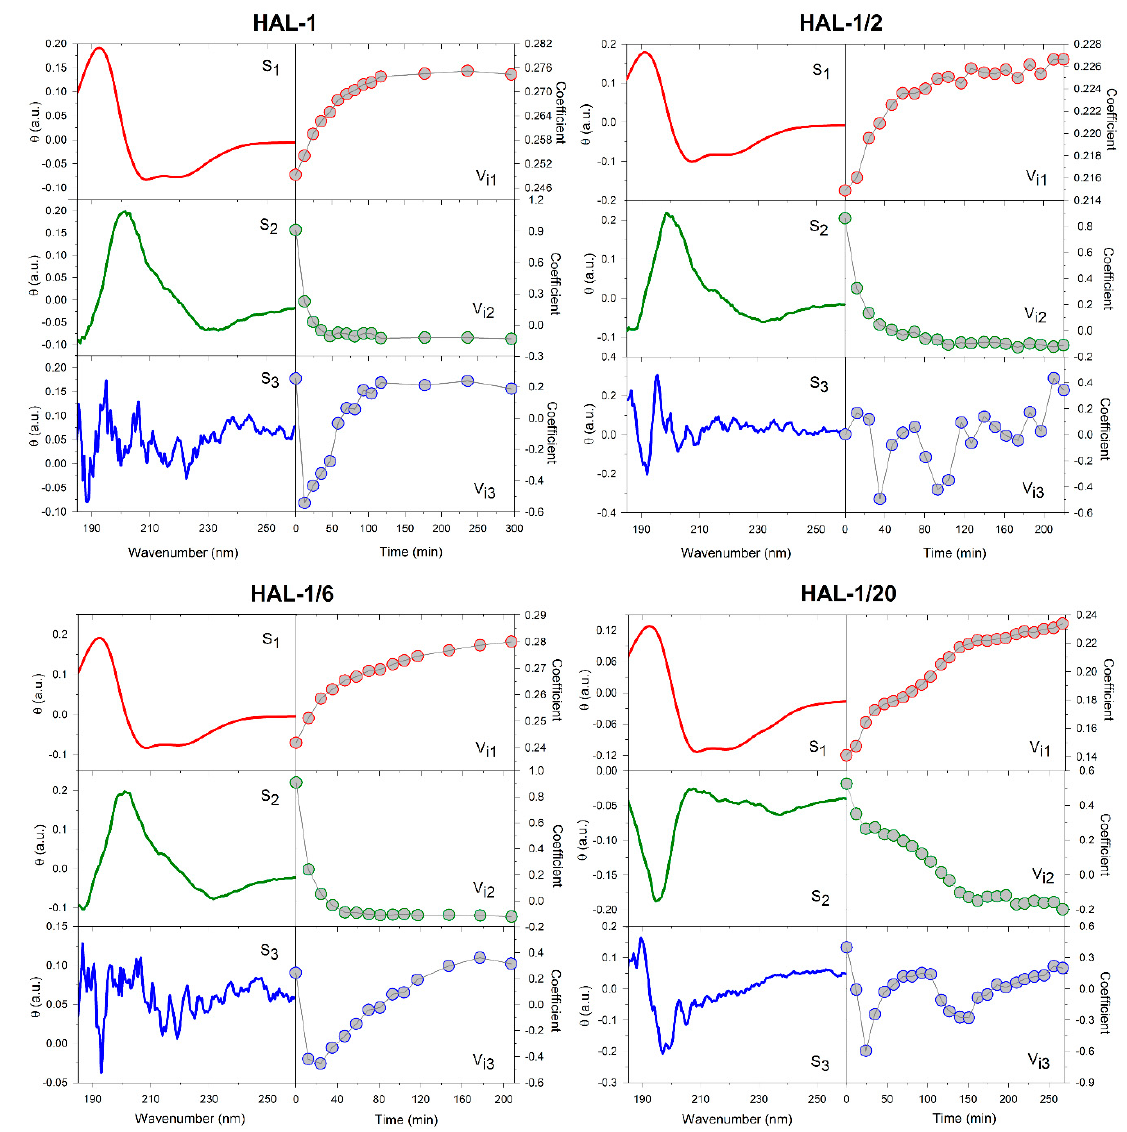
Figure A2. PCA results applied to the set of time dependence of ECD spectra of HAL-1 and its analogs in PC/PG = 1:4 mixtures measured within a 220 minute time interval after the sample preparation with a 12-minute time step. S j represents the three most significant subspectra and V ij represents the appropriate coefficients indicating the relative contribution of the corresponding subspectrum.